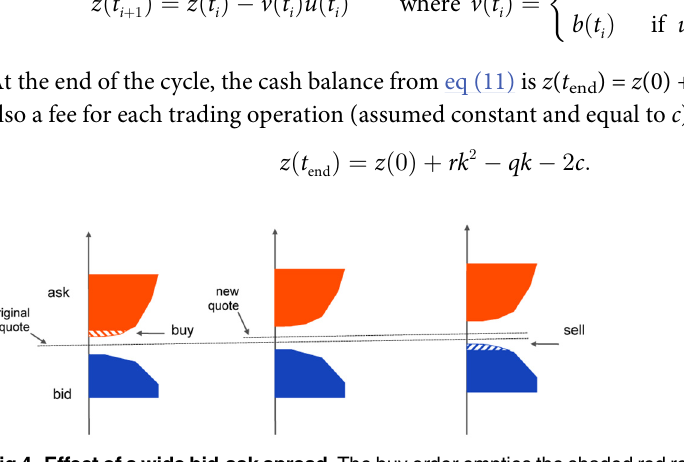
Fig 4. Effect of a wide bid-ask spread. The buy order empties the shaded red region of the ask side of the limit order book. The stock quote (midprice) consequently increases, while the best bid price (blue) remains unchanged. The sell order needed to complete the cycle settles at a price below the original buy price, hence the cycle results in a net loss for the trader.